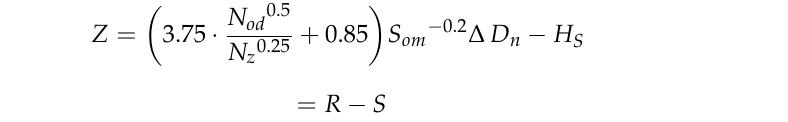
Figure 11. Comparison of Gaussian distribution of wave slope om